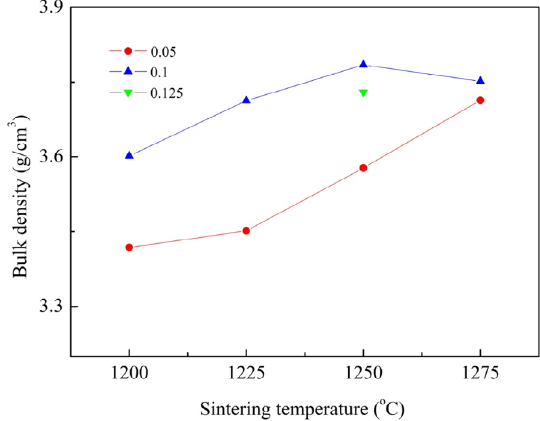
Fig. 5 Bulk density of Li 3 Mg 2 Sb 1– x O 6 ceramics following sintered at 1200–1275 ℃